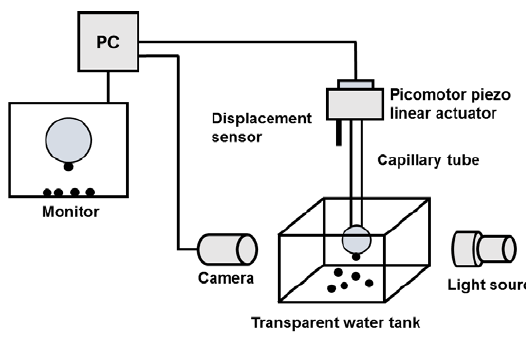
Figure 2. Induction time measurement system.